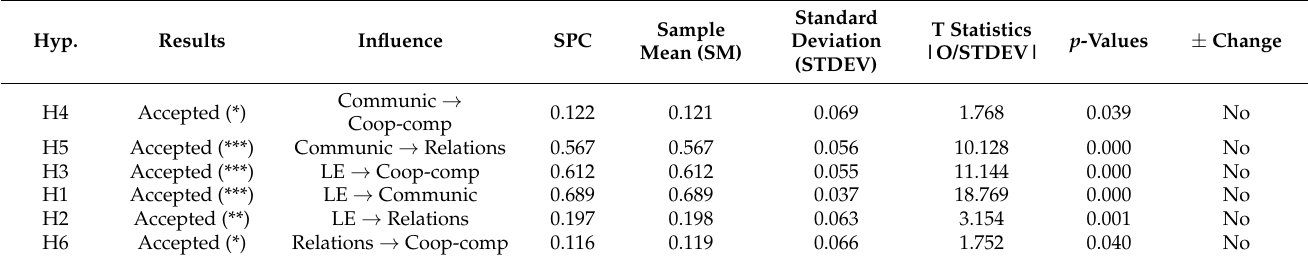
Table 5. Structural model results. Path significance using percentile bootstrap 95% confidence interval ( n = 5000 subsamples). Hyp.